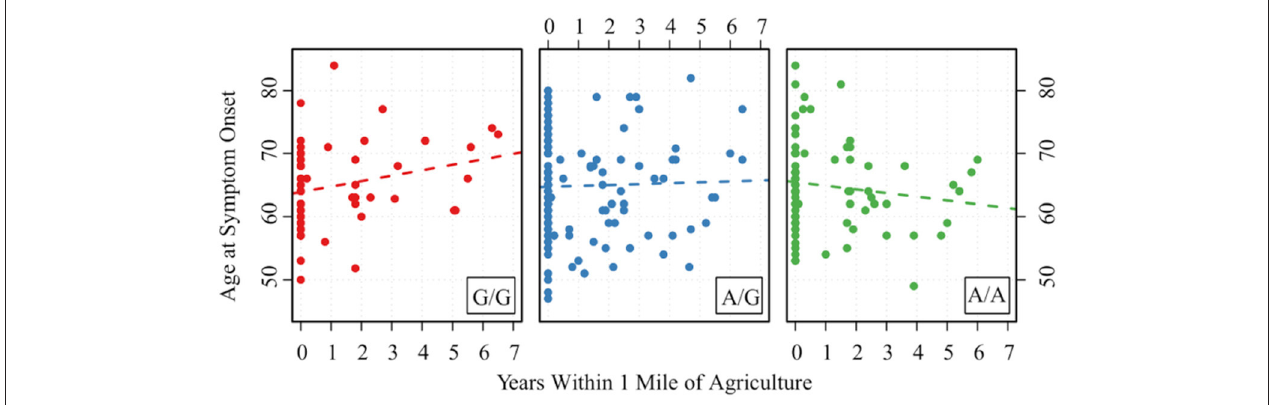
FIGURE 2 | Association between age of PSP symptom onset and the interaction of MAPTrs242557 and years of living within 1mile of agriculture. A is the minor allele, G is the major allele for MAPTrs242557; G/G corresponds to 0 minor allele, A/G corresponds to 1 minor allele, and A/A corresponds to 2 minor alleles.